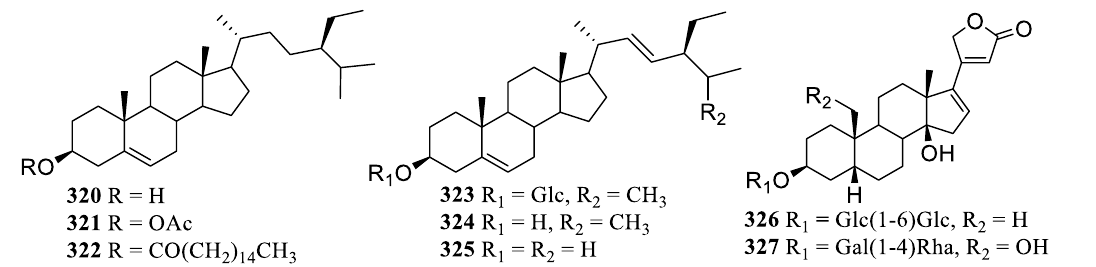
Fig. 6 The structures of steroids ( 320–325 ) and cardiac glycosides ( 326–327